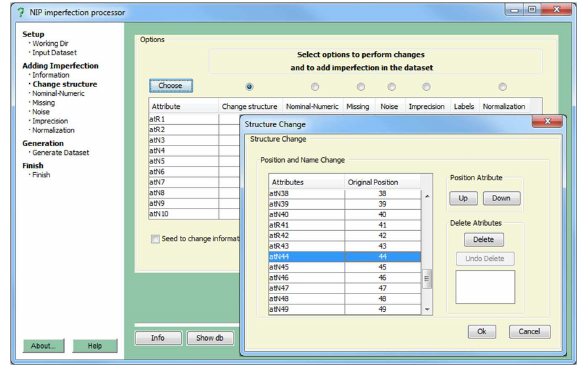
Fig. 9. A part of the “Inexpert-57.dat”